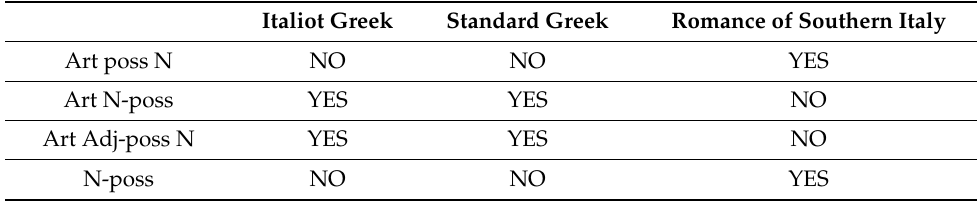
Table 7. Possessives: overlapping and non-overlapping